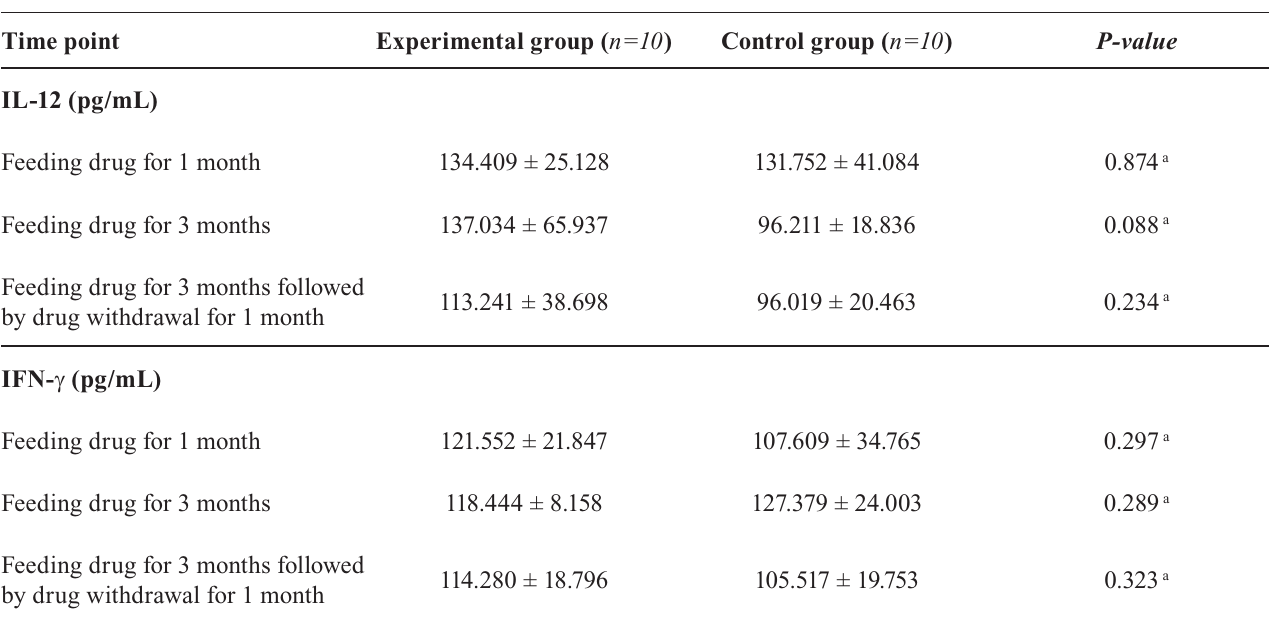
TABLE II - Comparison of IL-12 and IFN- γ level in the experimental and control groups at the three time